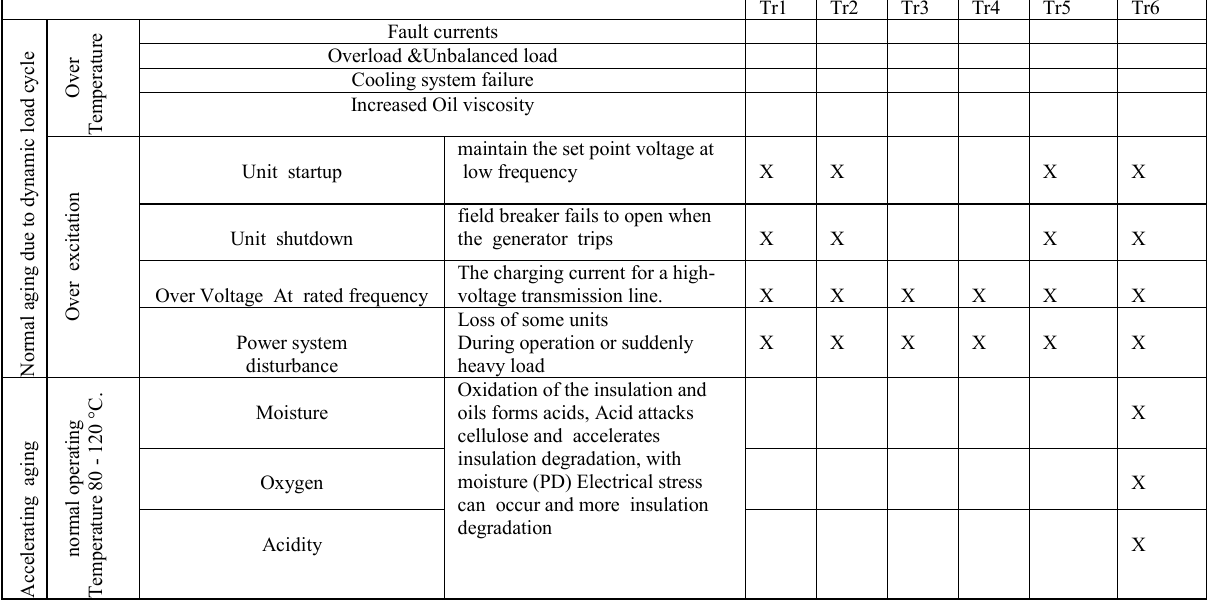
TABLE VI. CAUSES OF THERMAL FAULTS, NORMAL AND ACCELERATED